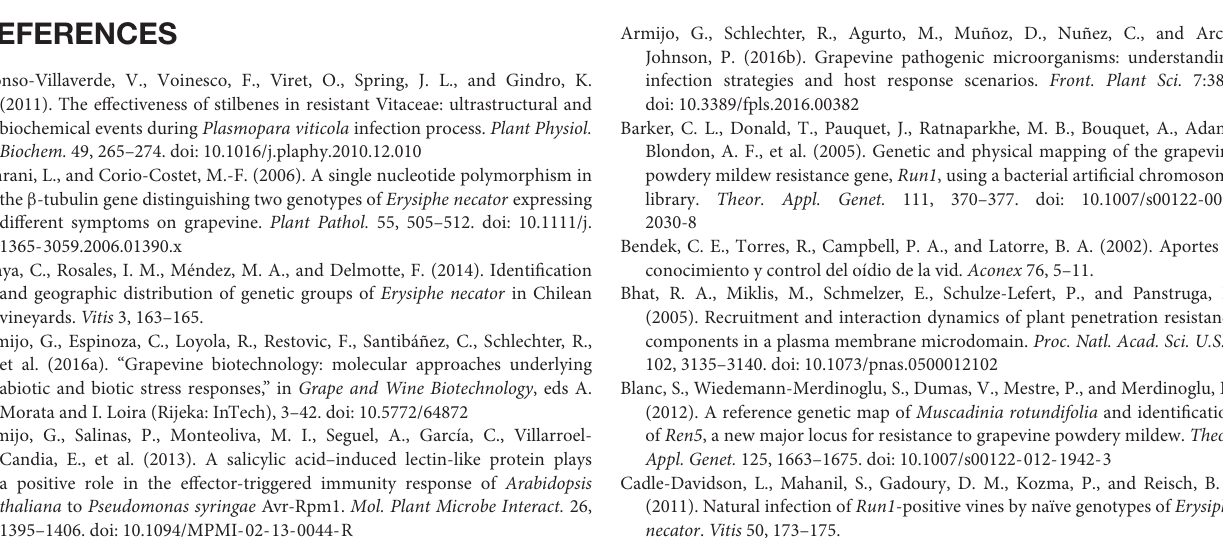
FIGURE S1 | Pseudo-backcrossing scheme of Erysiphe necator resistance sources with susceptible Vitis vinifera cultivars for RUN1 and REN1 pyramiding. Muscadinia rotundifolia : source of RUN1 ; Dzhandzhal Kara: source of REN1 ; NC, VRH and 02-2/81: RUN1 -positive genotypes; 91-4/27: REN1 -positive genotype; P09-105/34: RUN1REN1 -positive genotype; 105/34CS: segregating progeny carrying RUN1 and/or REN1 ; BCn: pseudo-backcrossing that originated the individual (Hoffmann, personal